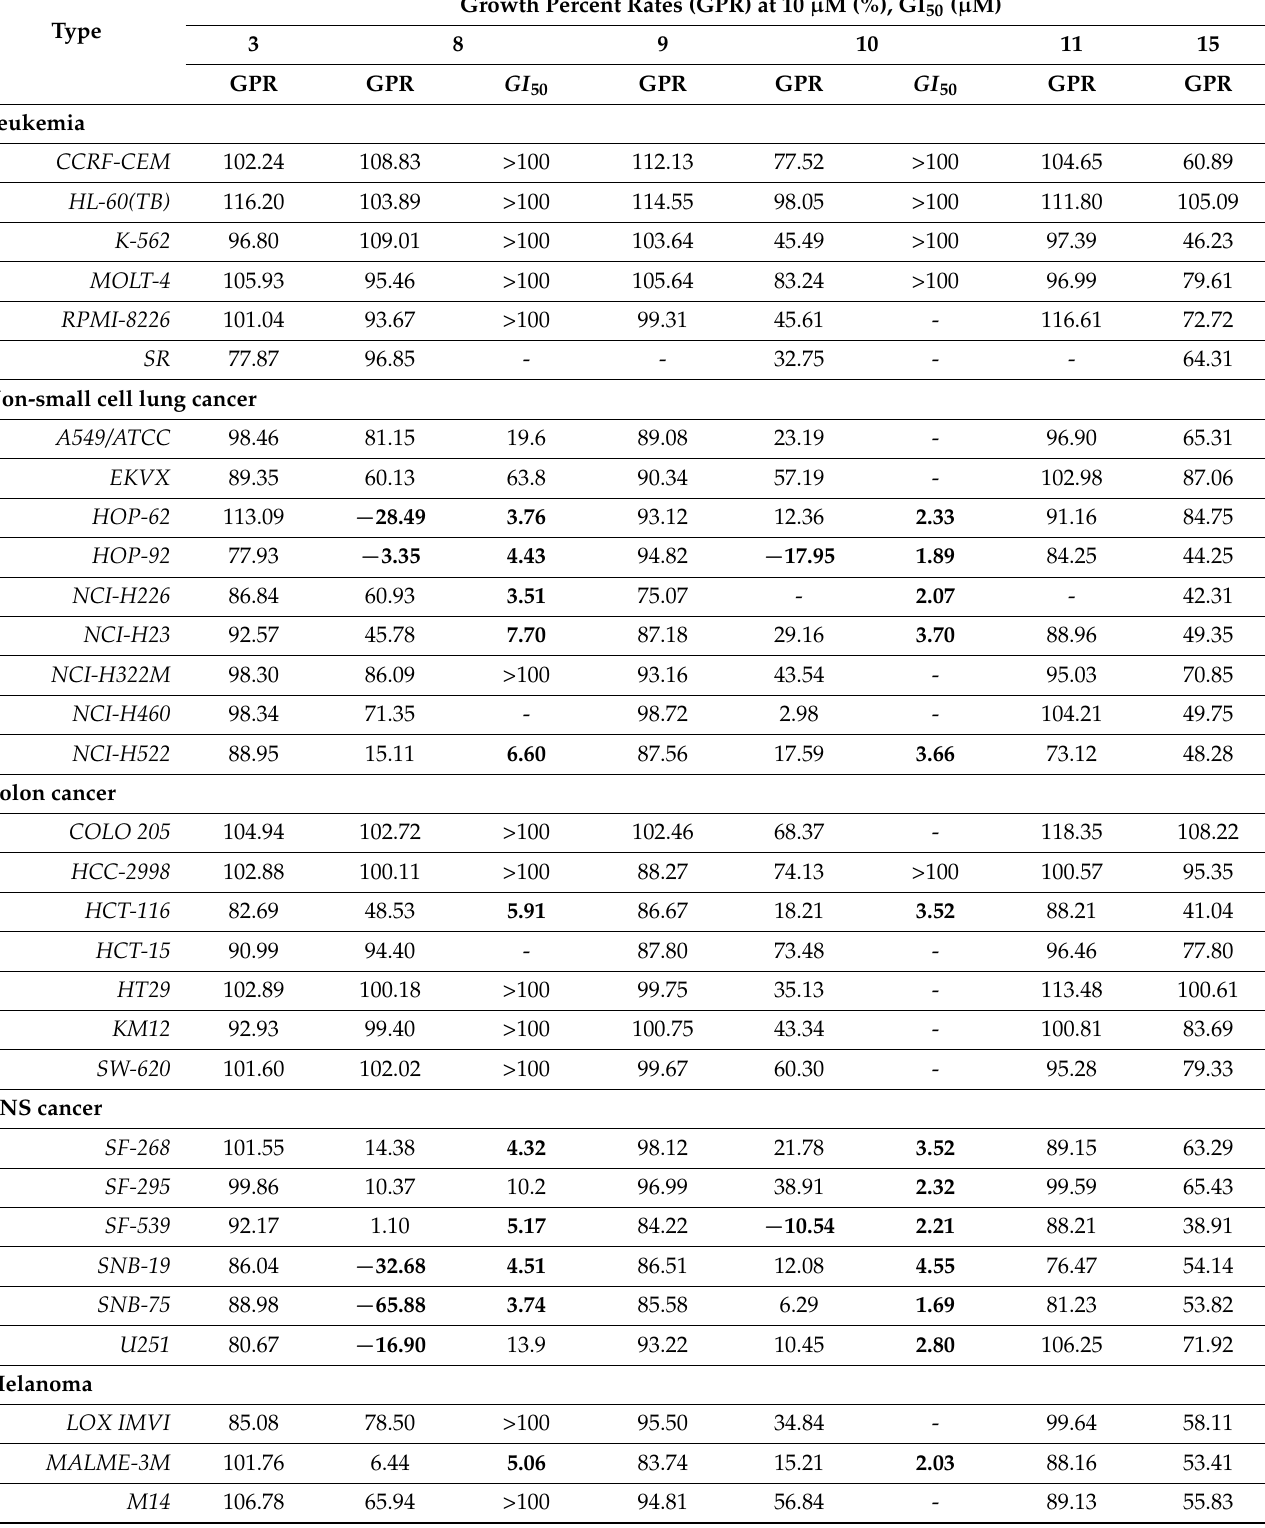
Table 1. Antiproliferative activities of chrysin ( 3 ), hybrids 8 – 11 and 15 against 60 human cancer cell lines in vitro. In connection with GPR values, the negative numbers causing cell death are highlighted in bold. Values where GI 50 < 10 µ M are highlighted in bold,